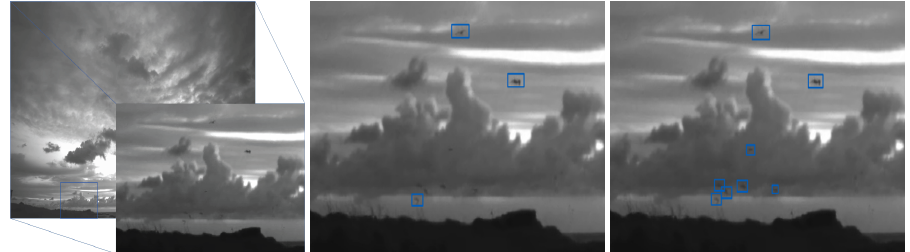
Figure 5. The effect of tiling on accuracy. Cropped region from the input frame with ground truth ( left ). Model 1 detection results cropped to match the input frame ( middle ) and Model 2 prediction results ( right ).